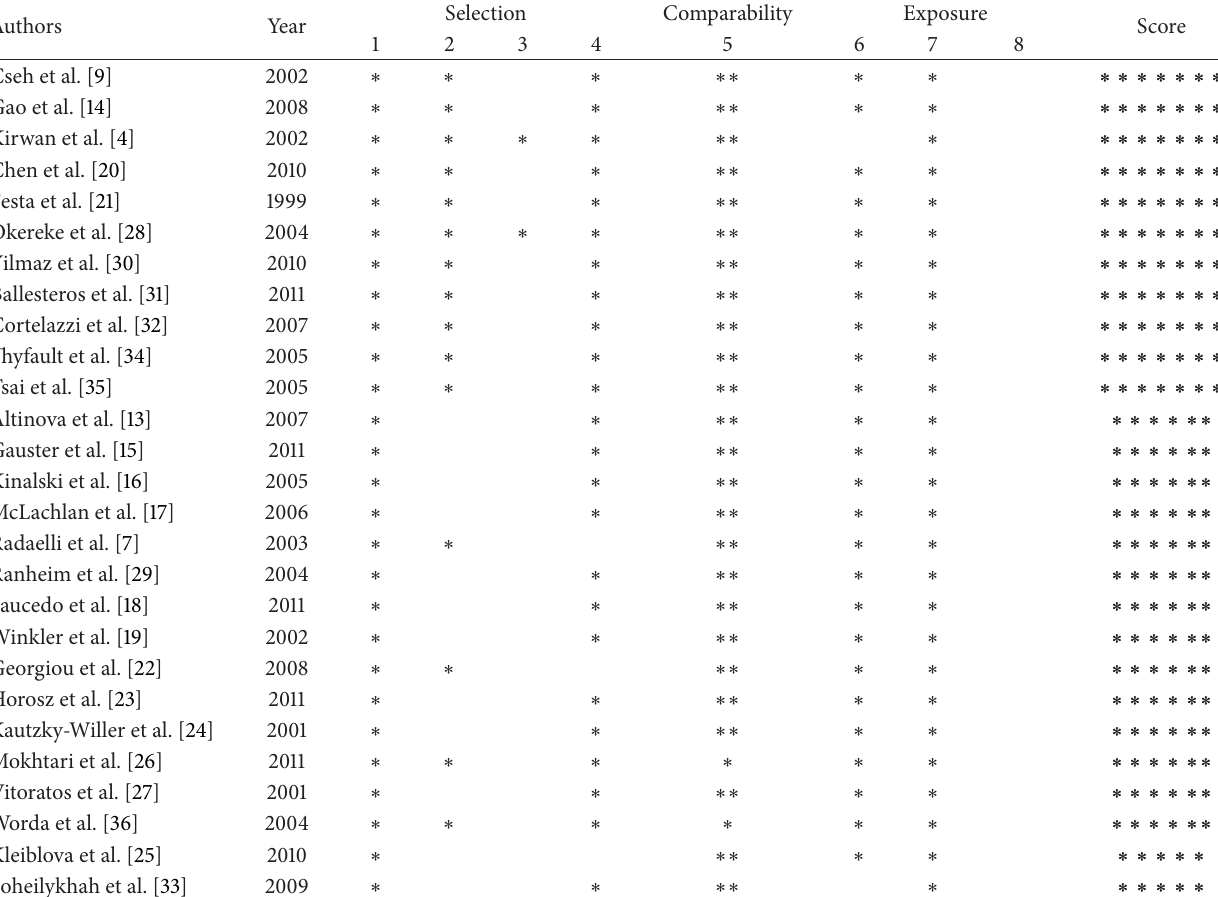
Table 2: Assessment of study quality.